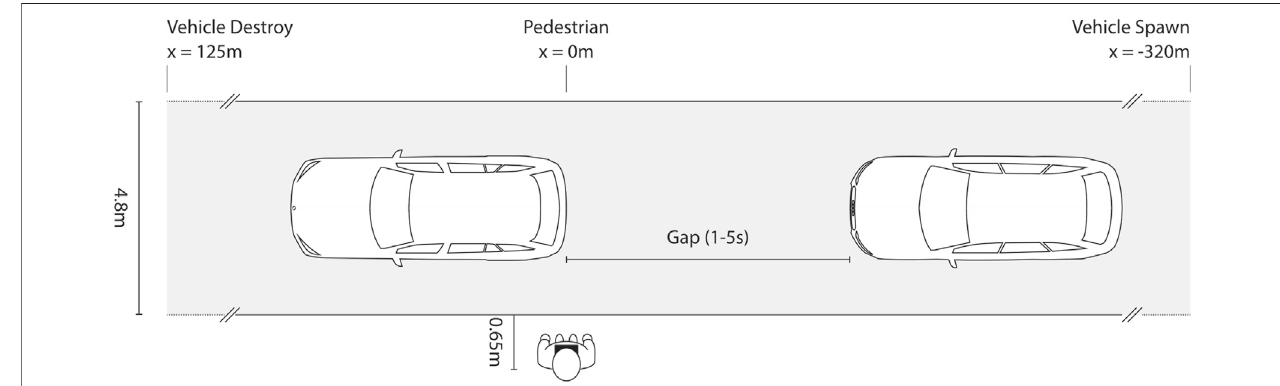
FIGURE 1 | Schematic sketch of the experimental setup. The virtual vehicles appear at a distance of 320 m on a 4.8 m wide road, pass by the subject at a prede fi ned speed and distance, and disappear at the end of the road.